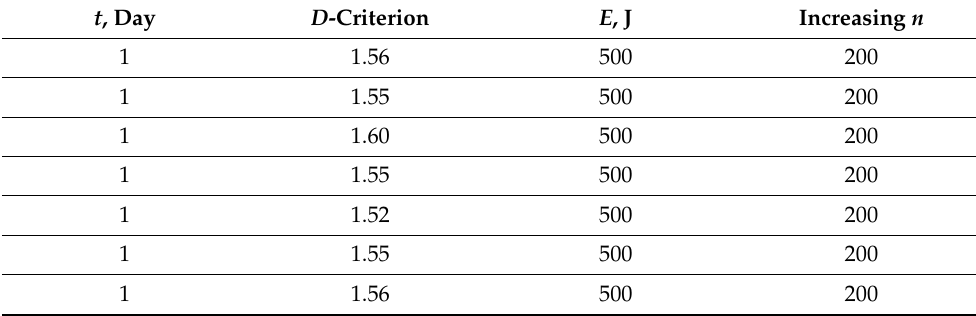
Table 3. Criterion assessment of the cell structure homogeneity.